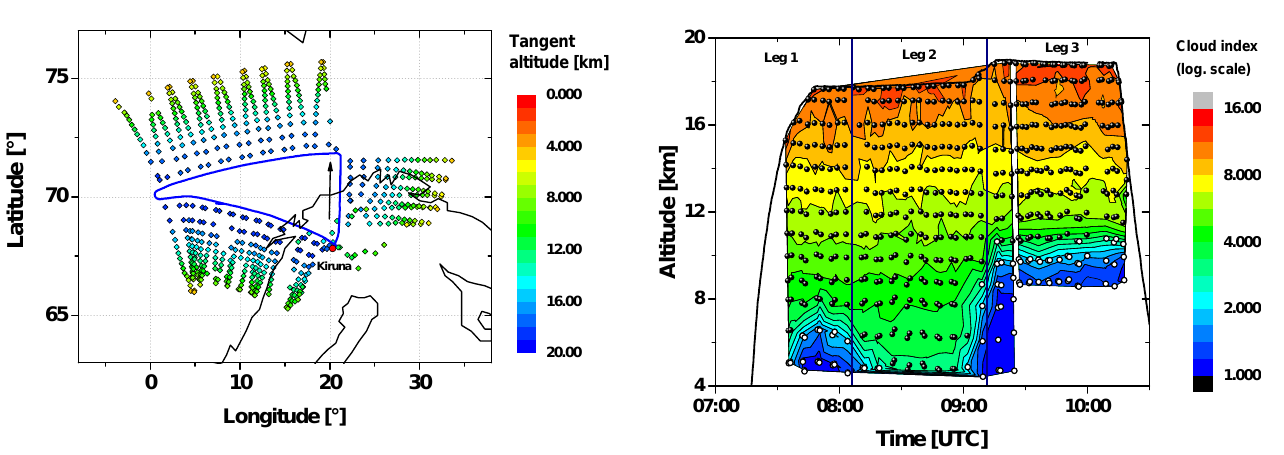
gent points and interpolated CI of the MIPAS-STR observations. White circles indicate MIPAS-STR observations showing CI val- ues lower than the adopted cloud threshold value of 3 (these spectra were omitted in the MIPAS-STR retrievals). CI values close to 1 indicate opaque